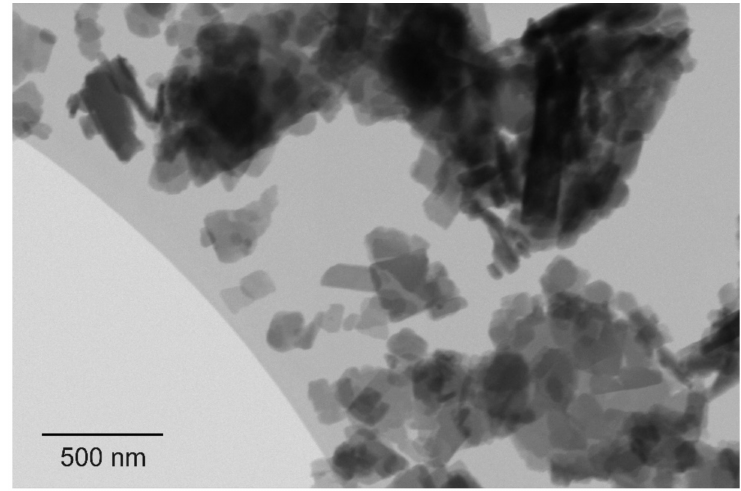
Figure 4. Scanning transmission electron microscopy image, showing primary particles of indigo with platelet morphology